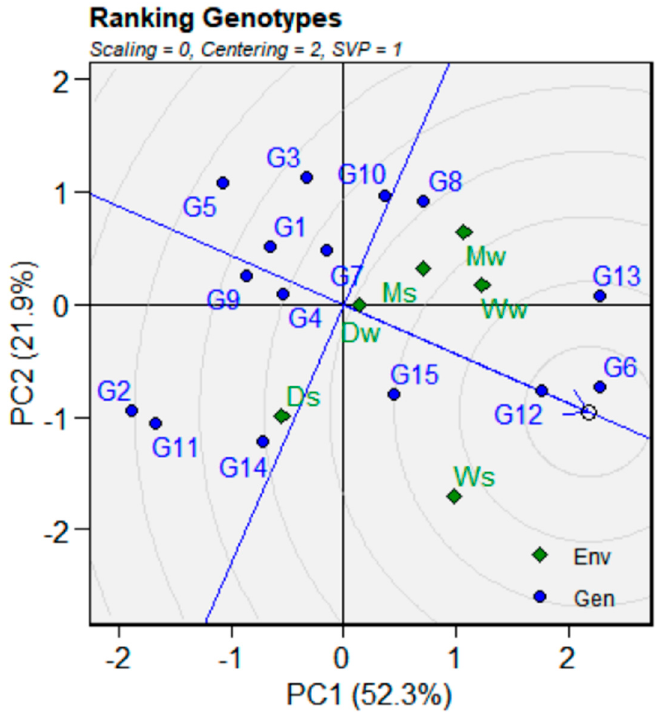
Figure 4. Genotypes yield comparison with reference to the ‘ideal’ genotype (center of circles) according to the GGE biplot method in southern Mozambique: Ds = Poorly watered in summer; Dw = Poorly watered in winter; Ms = Moderately watered in summer; Mw = Moderately watered in winter; Ws = Well ‐ watered in summer; Ww = Well ‐ watered in winter.